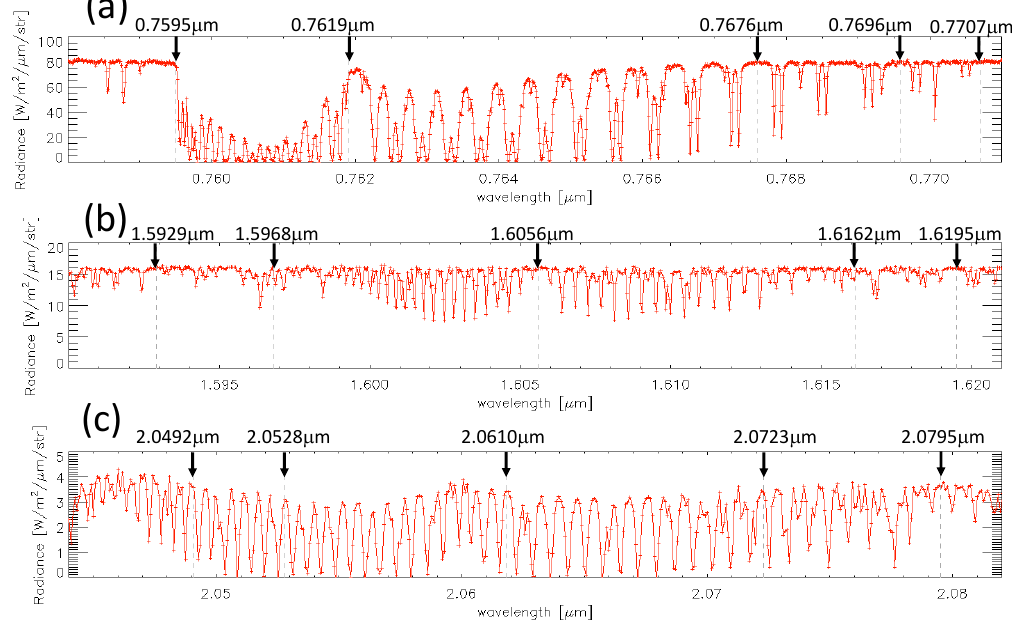
Figure 2. The wavelengths evaluated in each band; ( a ) ABO2; ( b ) WCO2 ( c ) SCO2 bands.